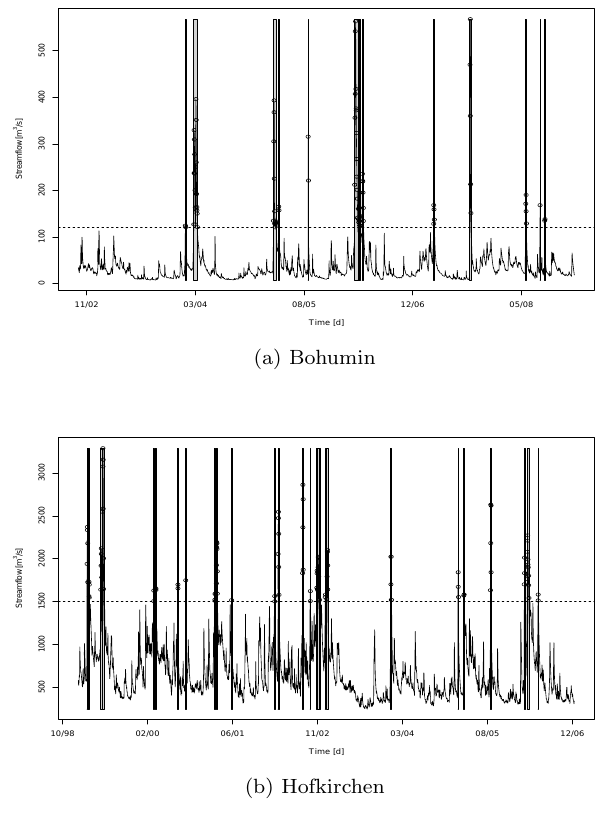
Fig. 1. Observed stream-flow and number of clusters exceeding a threshold at station (a) Bohumin (Odra, CZ) and (b) Hofkirchen (Danube, DE) with 6, resp. 8yr of daily